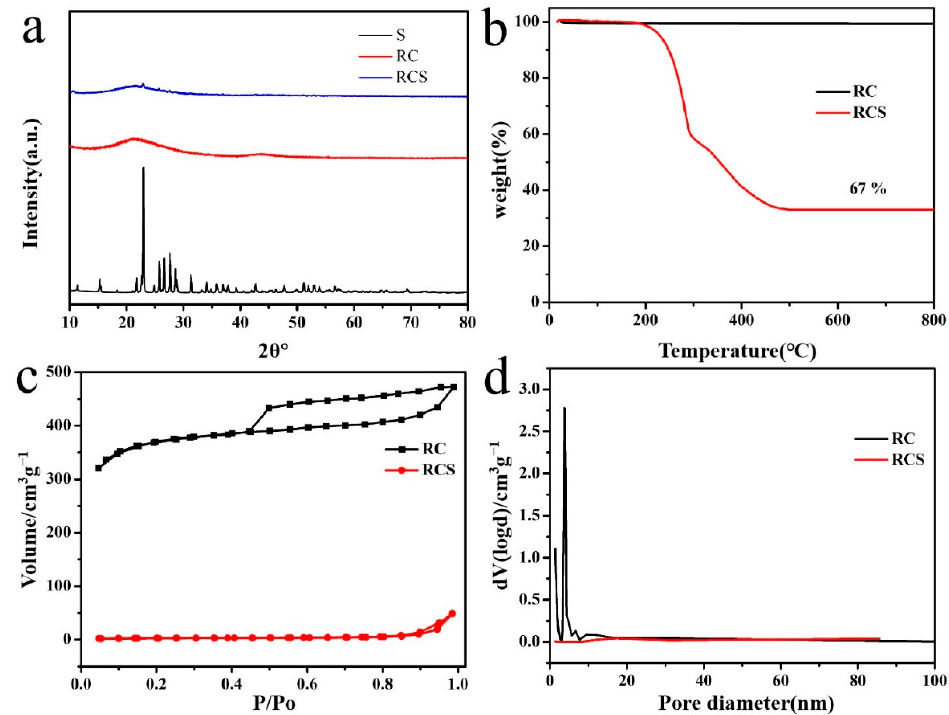
Figure 5. ( a ) XRD patterns of sulfur, RC and RCS, ( b ) TG curves of RC and RCS, ( c ) N 2 sorption isotherms of RC and RCS and ( d ) pore size distributions of RC and